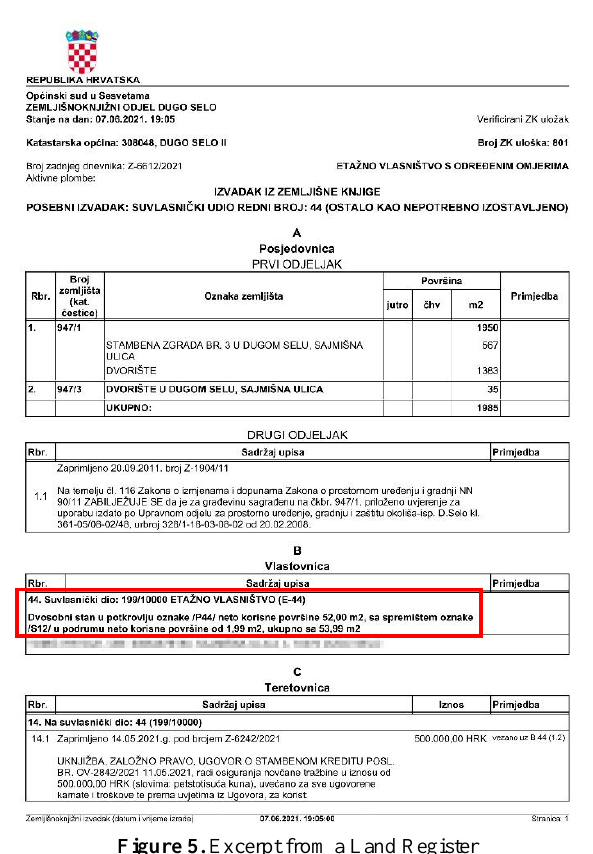
Figure 5. Excerpt from a Land Register